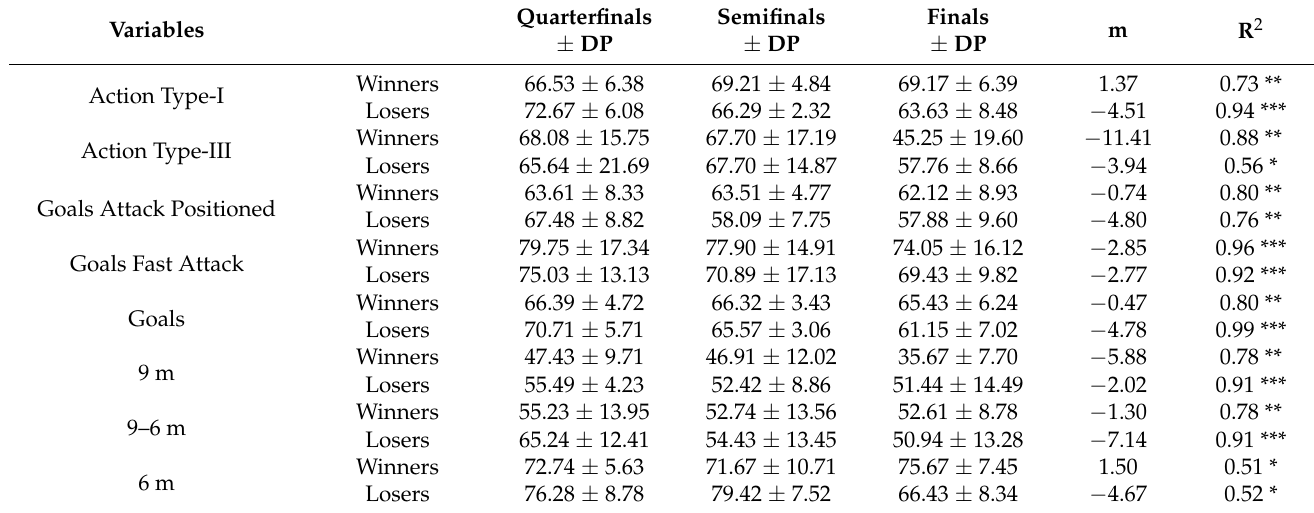
Table 3. Descriptive analysis of the effectiveness of shooting performed in